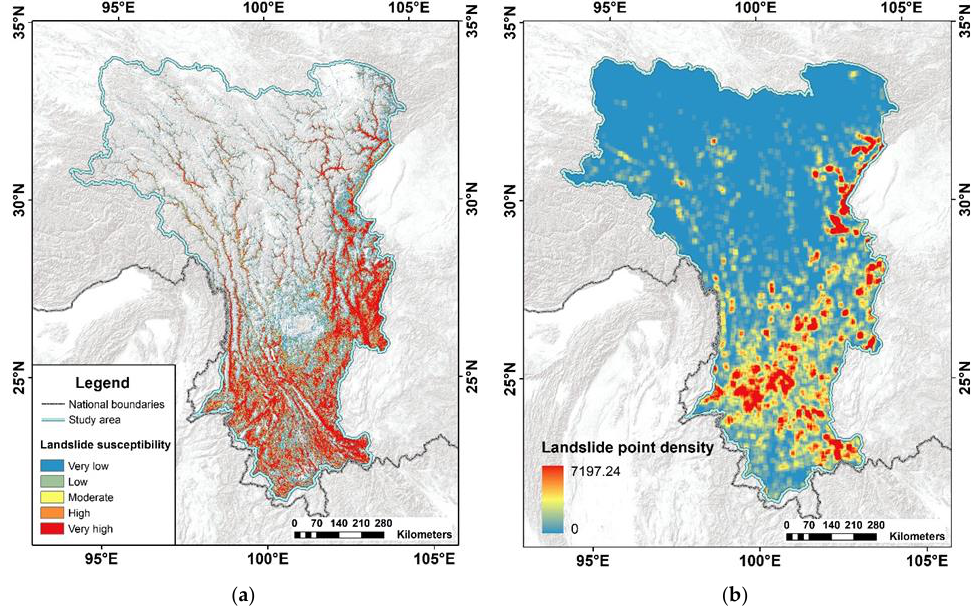
Figure 8. Landslide susceptibility assessment results and comparison with investigation landslide data. ( a ) Landslide susceptibility map; ( b ) landslide point density map based on the data of Resource and Environment Science and Data Center of the CAS.